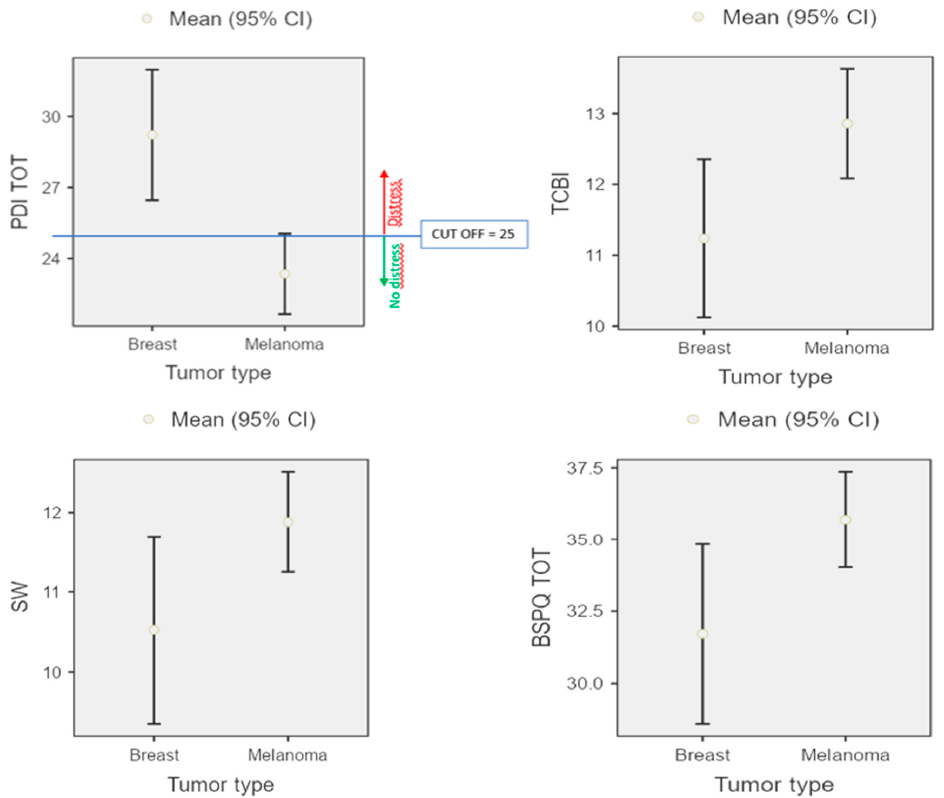
Figure 2. Psychological distress and self-body perception representation of both Bg and Mg groups.